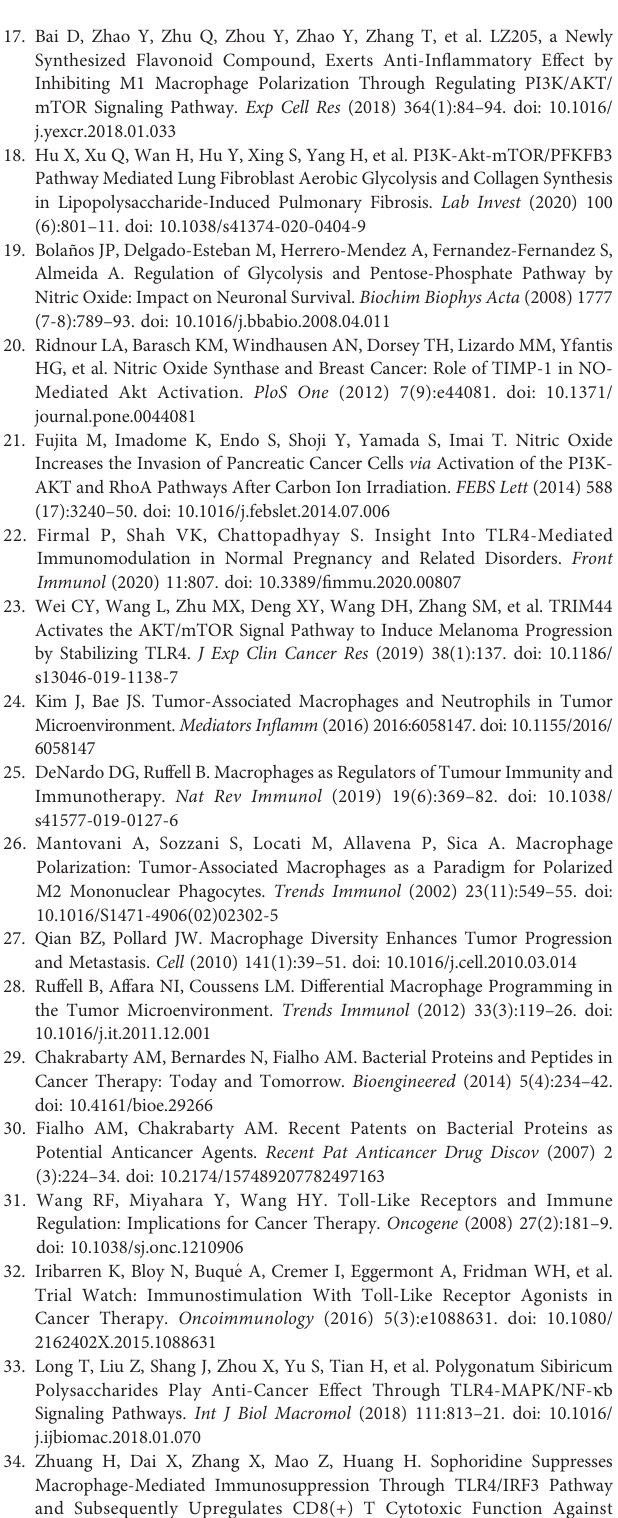
Supplementary Figure 8 | PcrV-primed BMDMs, but not TLR4 -/- or MyD88 -/- BMDMs, suppress tumorgrowth. (A) Schematic ofthe mouse models used.Tumor growth (B) and weight (C) were measured in LLC cell-derived tumor-bearing mice